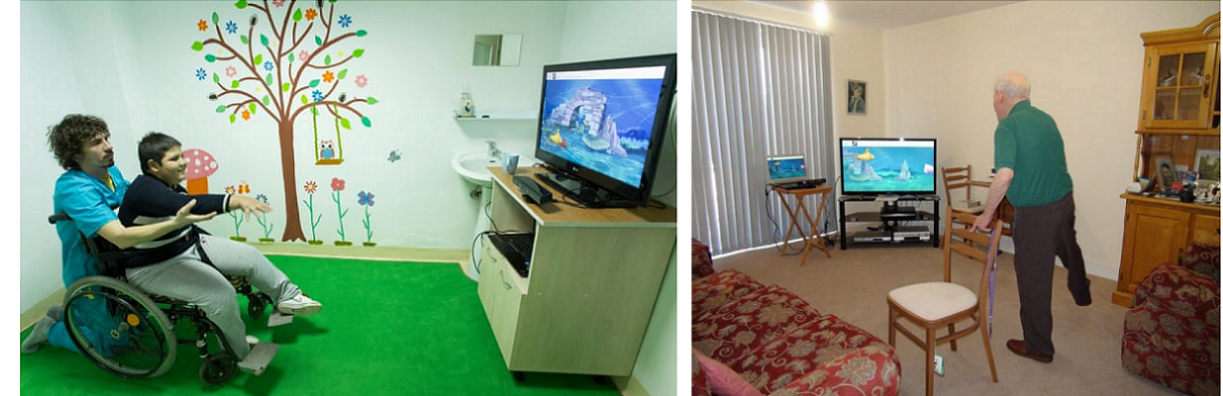
Figure 1. Medical Interactive Recovery Assistant system including a Kinect motion sensor and software to match an exercise with a game. A child (left) and an elderly gentleman (right) playing the Atlantis game. The child is practicing an arm exercise, the gentleman a hip